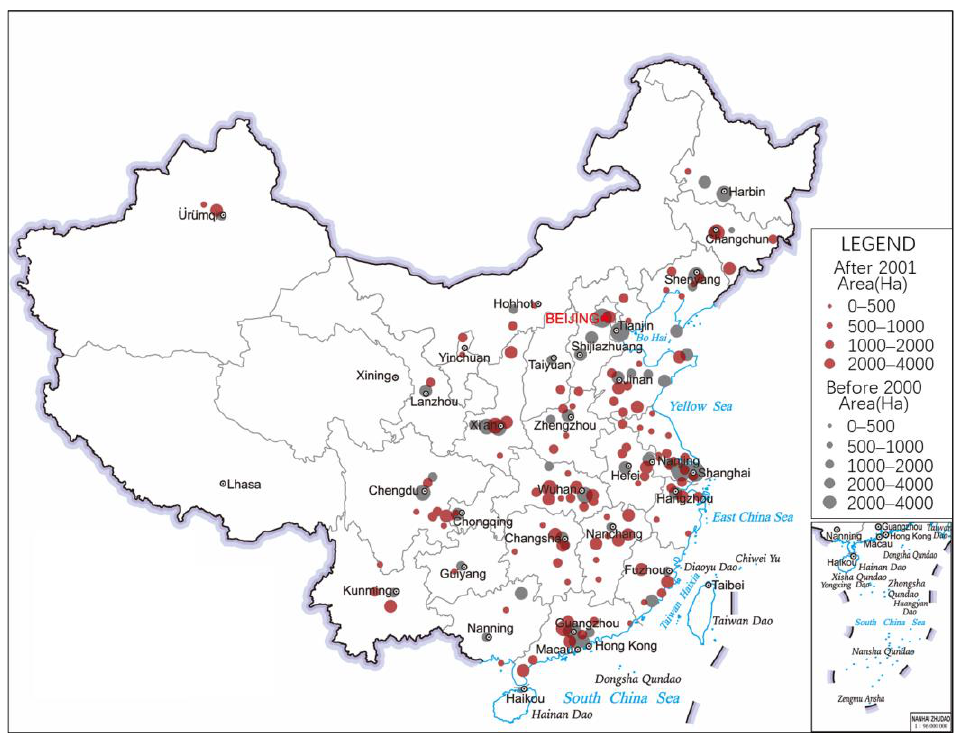
Figure 2. The Distribution of HIDZs in China (1988−2019) (Source: The authors, as amended based on the Directory of Chinese Development Zones Approval Announcement (2018 Edition). The base map refers to the standard map of Ministry of Natural Resources of PRC, No. GS (2019) 1673).